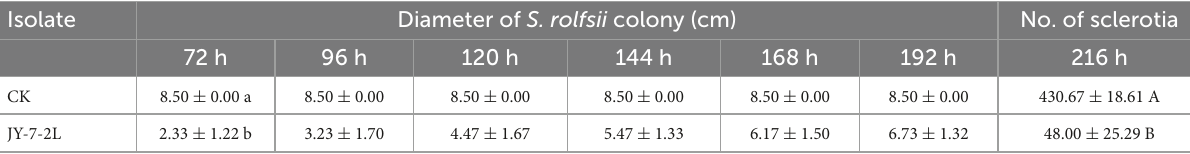
TABLE 2 Effect of cell-free culture filtrate of strain JY-7-2L on hyphal growth and sclerotia formation of Sclerotium rolfsii . Isolate Diameter of S. rolfsii colony (cm)